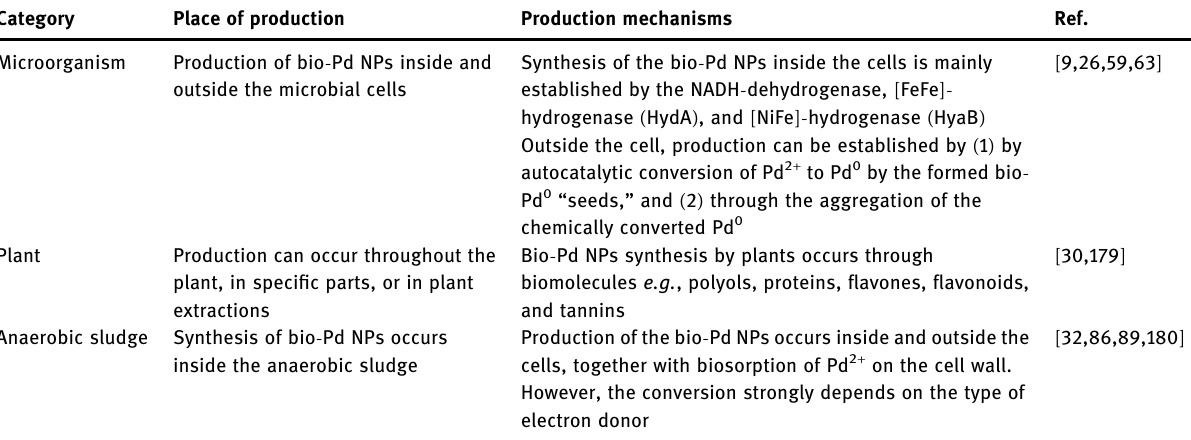
Table 1: Overview of the di ff erent bio - Pd NPs production methods and mechanisms for microorganisms, plants, and anaerobic sludge